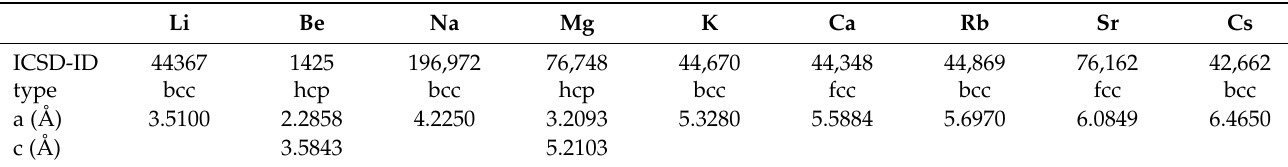
Table 1. Experimental crystal structure parameters taken from the inorganic crystal structure database (ICSD) [24,25].